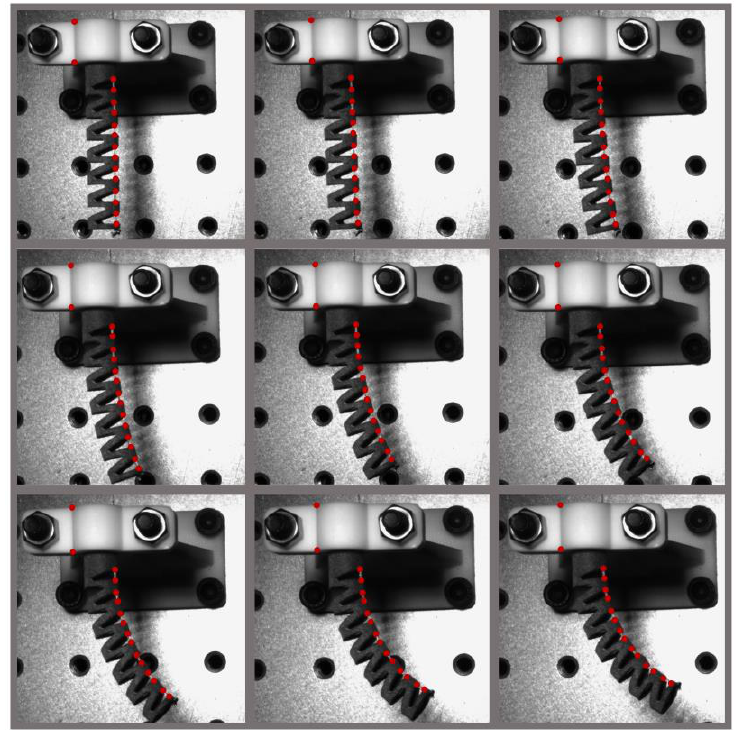
Figure 11. Bending of NCR with seven notches under different forces.